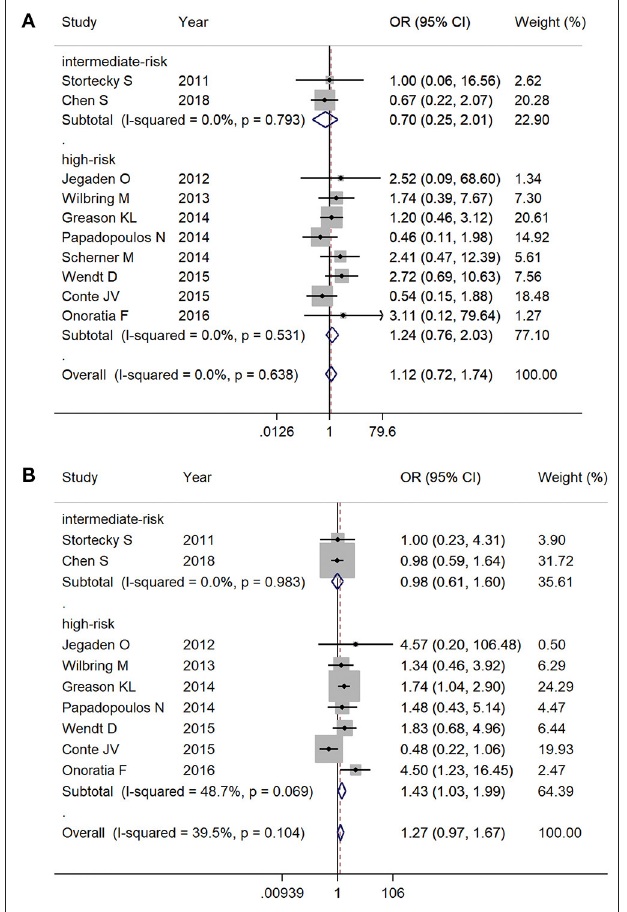
FIGURE 4 | Subgroup analysis by surgical risk classification: (A) 30-day mortality and (B) overall follow-up mortality.